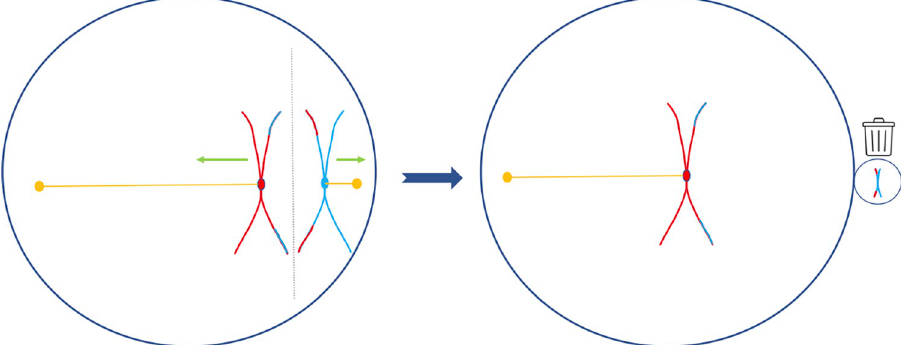
Fig 1. The 3 asymmetries of maternal meiosis I. Here, we consider only 1 of our 23 pairs of chromosomes. Each chromosome, as inherited from the mother or father, is coloured either red or blue. The first step of meiosis I is to replicate each chromosome, generating an X-shaped structure pinched at the centromere (circle at the pinch point of the chromosomes). After meiosis I crossing-over, the chromosome arms swap so causing a change from blue to red of vice versa. The chromosomes in the left figure are seen at this stage. However, with no crossing over at the centromere, segregation during meiosis I always segregates unrelated maternal and paternal centromeres (the relatedness asymmetry). The centromeres attach to spindle microtubules (orange line) that pull the relevant chromosome in 1 of 2 directions. Here, the centromeres and associated kinetochores are shown as 1 entity per chromosome. In reality, there are 2 that tend to co-orient on the same chromosome. One centromere will be dragged to the small polar body, this having no reproductive future (illustrated by a bin), the other to the egg pole, this one then entering meiosis II and having a future. This is the fate asymmetry. The small size of the polar body compared to the egg creates a size asymmetry. The chromosomes align across the meiotic plate (dotted vertical line). Owing to the size asymmetry, this is often located towards where the polar body will appear. This creates a vulnerability in that centromeres can in principle gain information as to which pole they are being dragged, owing to gradients that run across the